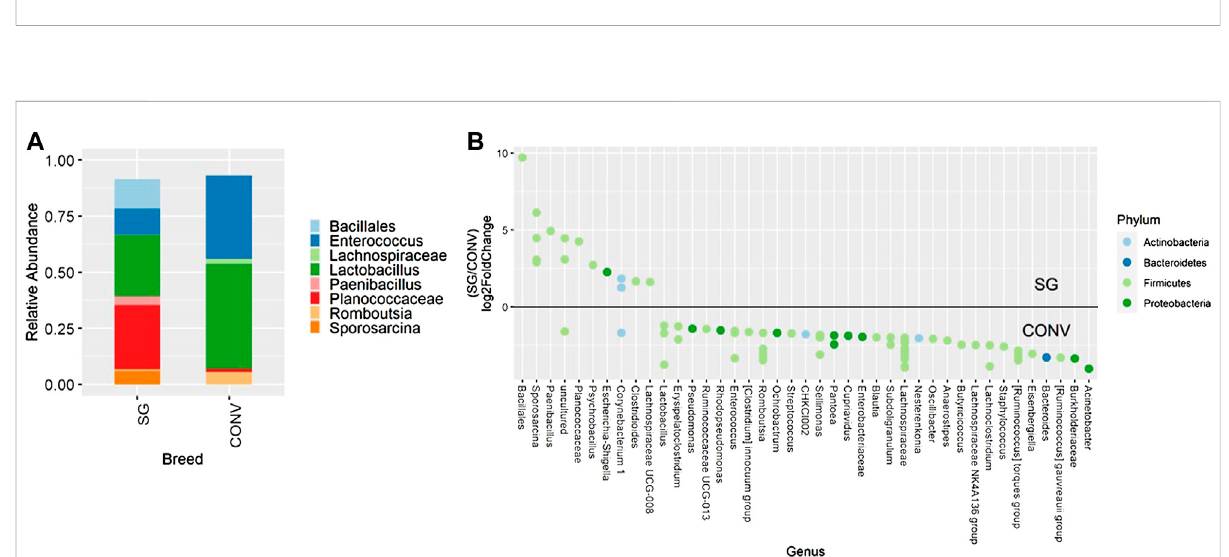
FIGURE 3 Relative abundance of genera in the ileum on day 7 that are present in greater than 2% of total taxa found in conventional (CONV) and slow- growing (SG) broilers (A) . Differentially abundant amplicon sequence variants (ASVs) between broiler genetic lines in the ileum on day 7 (B)